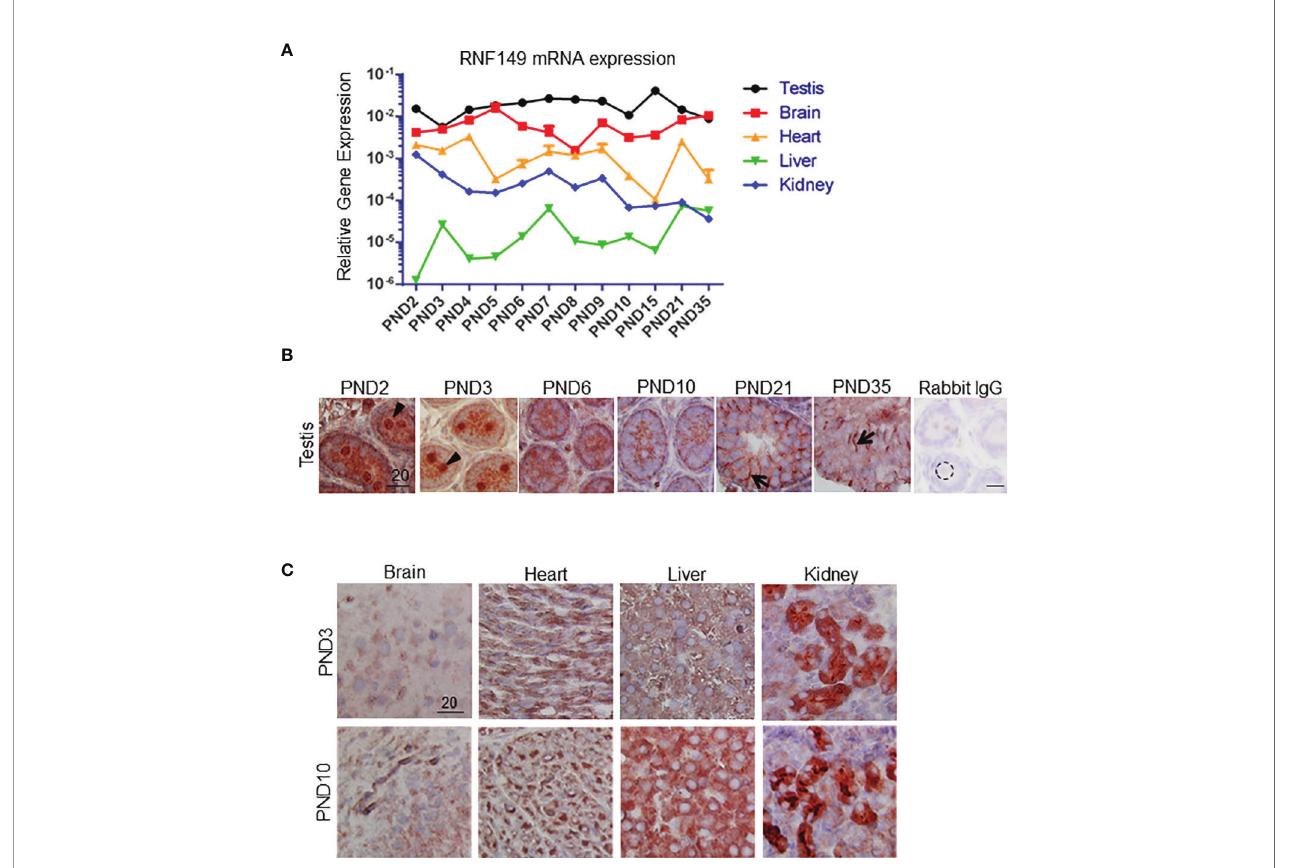
FIGURE 1 | RNF149 expression pro fi le in various organs in rats at various ages. (A) RNF149 mRNA levels in various tissues from PND2 to PND35. (B) RNF149 protein expression in testes from PND2 to PND35. Arrowhead: germ cell; arrow: Sertoli cell. (C) RNF149 expression in brain, heart, liver, and kidney at PND3 and PND10. 20 m m scale shown. Representative images